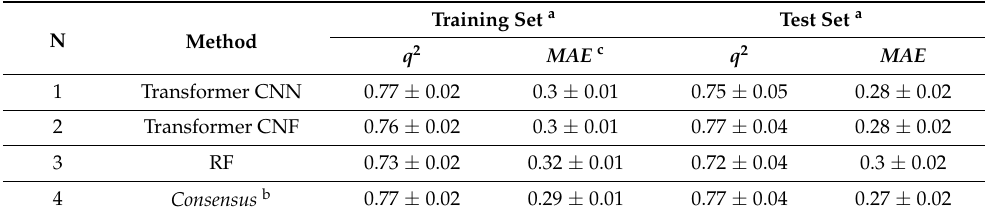
Table 1. Statistical coefficients of the regression models to predict antioxidant